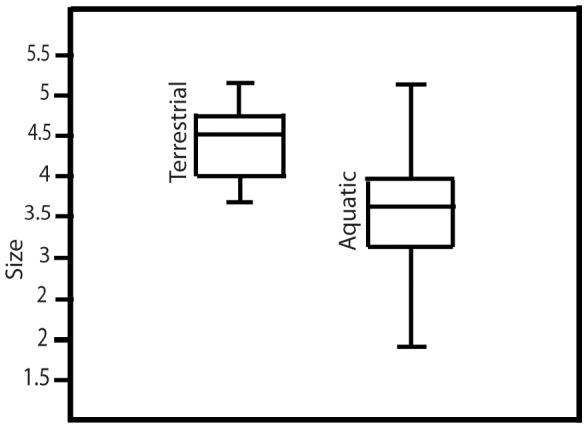
Box plot comparing cross-sectional size (log µm) for cut-marks on aquatic and cut-marks on terrestrial fauna.